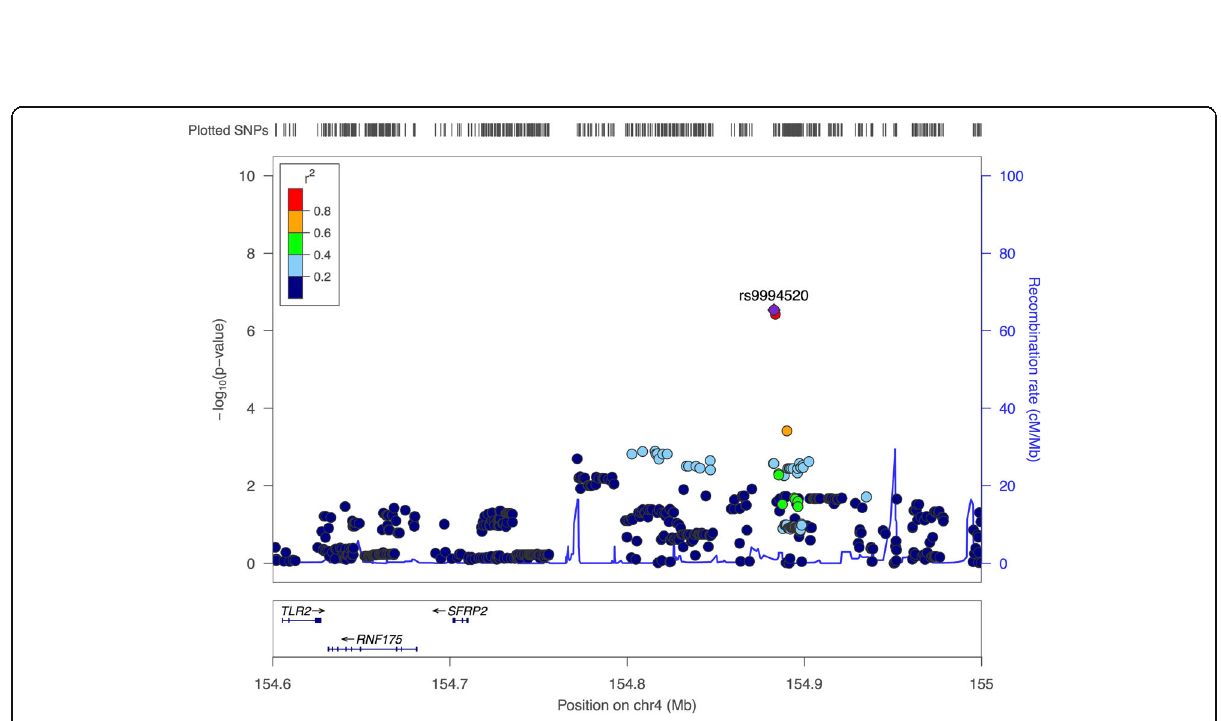
Fig. 4 pQTL association signals during weight loss in the region surrounding rs9994520 and SFRP2 gene. Association plot produced using LocusZoom software for SNPs associated to ANGPTL3 protein level change during weight loss intervention. SNPs ’ p values are plotted after − log10 transformation with scale on the y -axis and colors reflect pairwise linkage disequilibrium with the most associated SNP in the region (purple dot) based on the 1000 genomes EUR data set